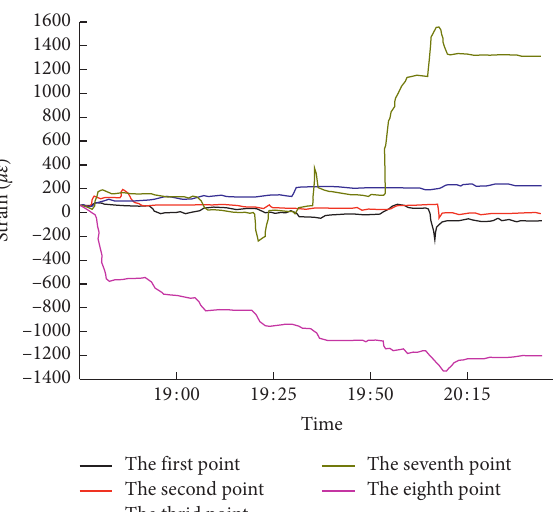
Figure 19: Vertical strain versus time curve for each key